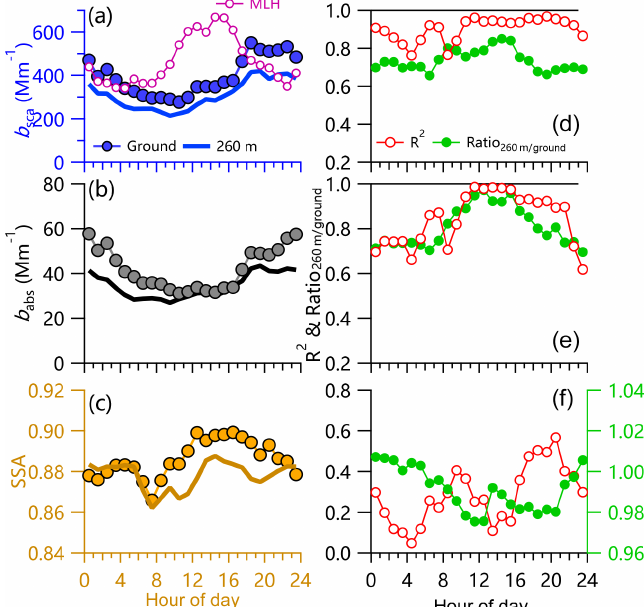
Figure 6. Diurnal cycles of (a) b sca , (b) b abs , and (c) SSA at 260m and ground level for the entire study. Panels (d, e, f) show the diurnal cycles of correlation coefficients ( R 2 ) and ratio 260m / ground for b sca , b abs , and SSA. Note that the diurnal cycles above excluded five periods with cleaning processes (19 November 01:00 to 09:00, 26 November 01:00 to 12:00, 26 November 19:00 to 27 November 03:00, 3 December 20:00 to 4 December 16:00, and 17 December 00:00 to 12:00) while those of entire study are shown in Fig. S3.